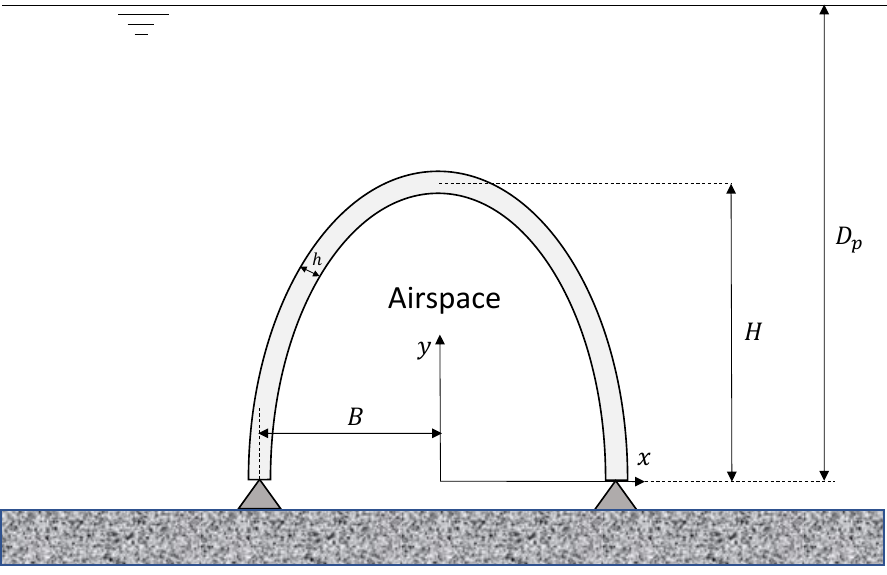
Figure 1. Geometry of a submerged